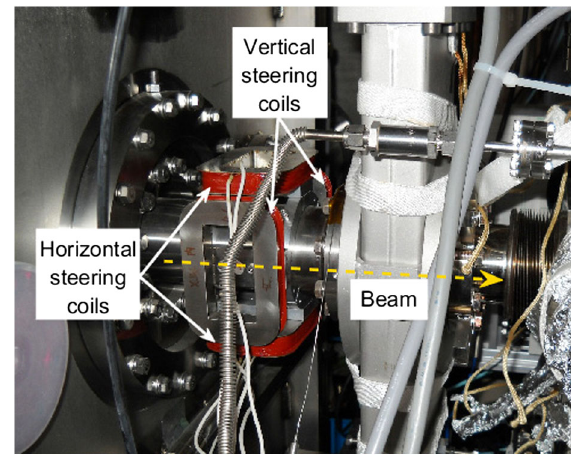
FIG. 16. Photograph of cERL injector steering coils. The electron beam travels from the left to the right. Two pairs of rectangular-shaped coils are placed in parallel to the beam line. A pair of rectangular-shaped coils on the left and on the right is used for vertical steering. Those at the top and at the bottom are for horizontal steering.